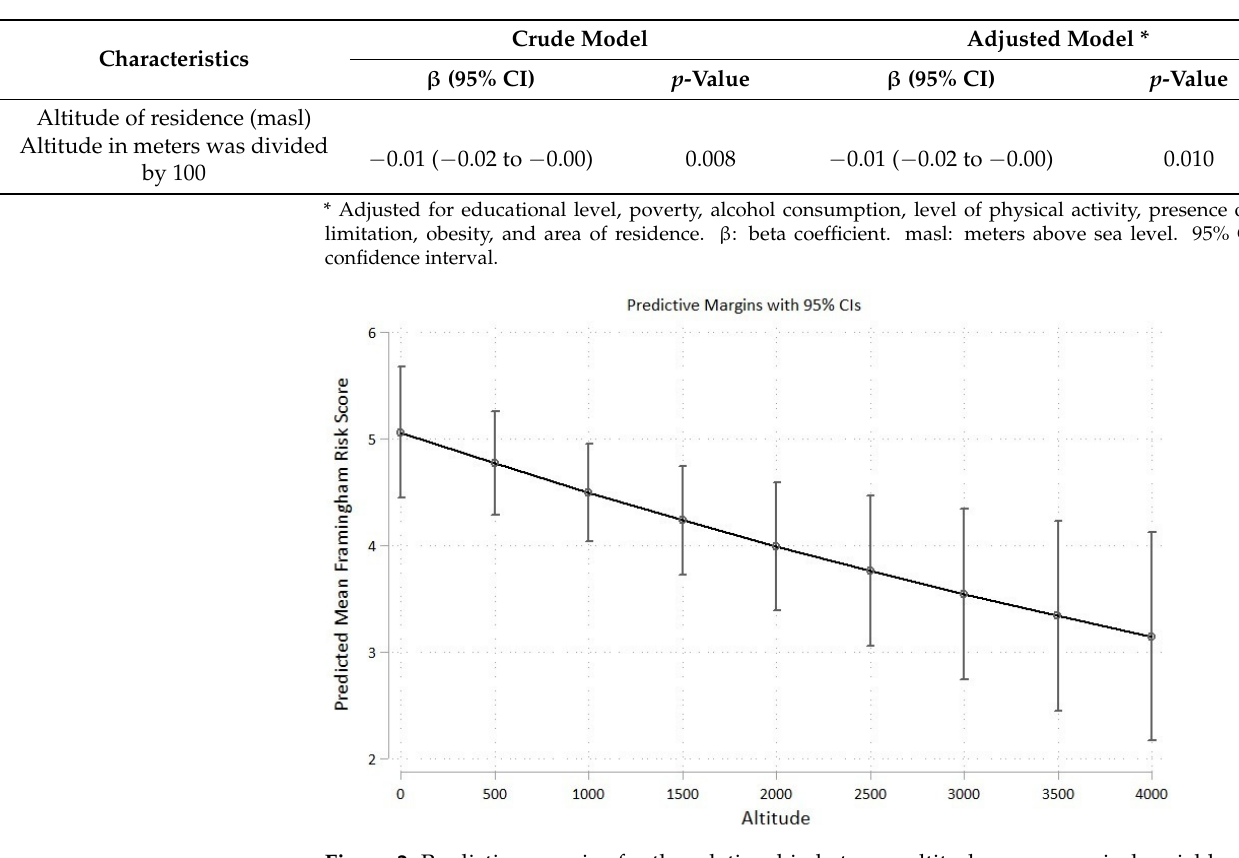
Table 5. Sensitivity analysis of the association between altitude as a numerical variable and the Framingham risk score.